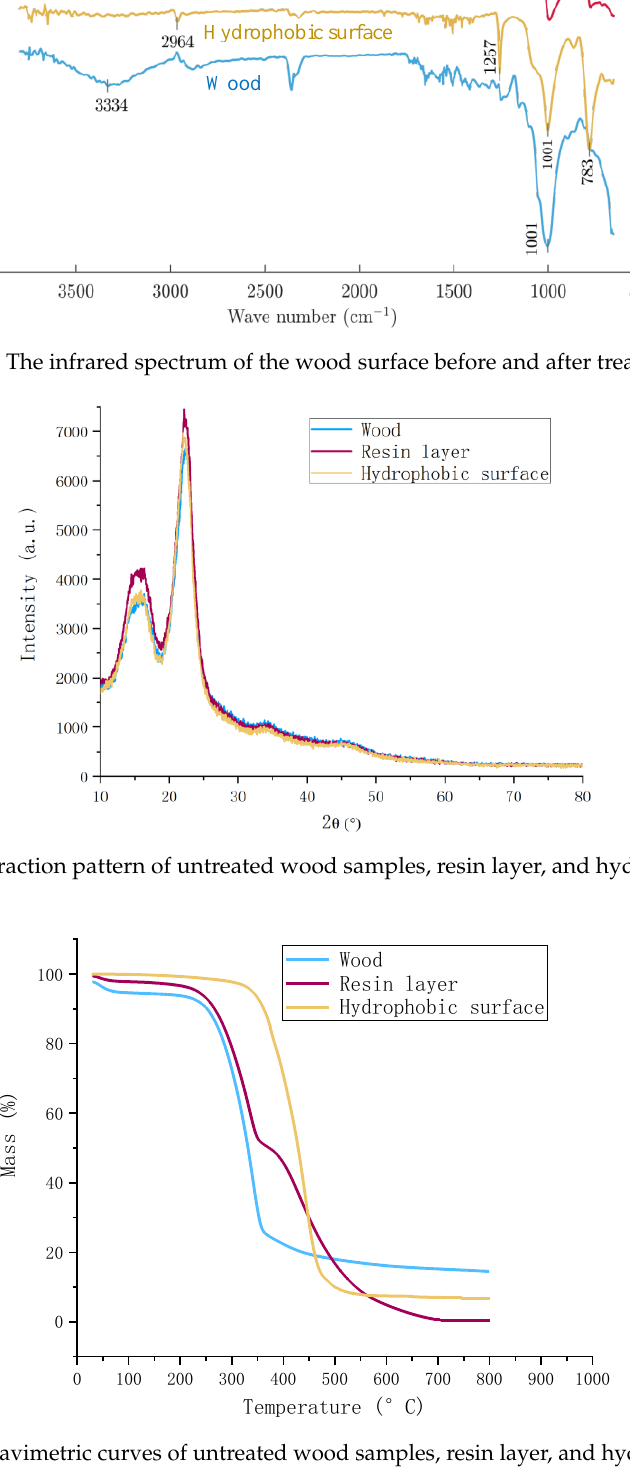
Figure 9. Thermogravimetric curves of untreated wood samples, resin layer, and hydrophobic surface on wood.